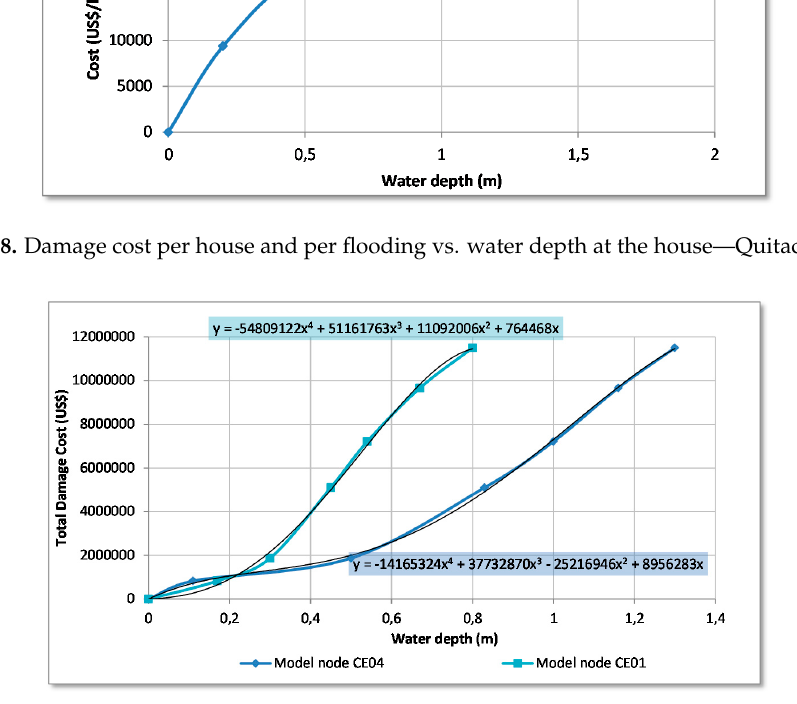
Figure 9. Depth–damage correlation: Damage cost per flooding event for the whole area vs. water depth at the control node. The total damage depends on water level in each house that is flooded. As